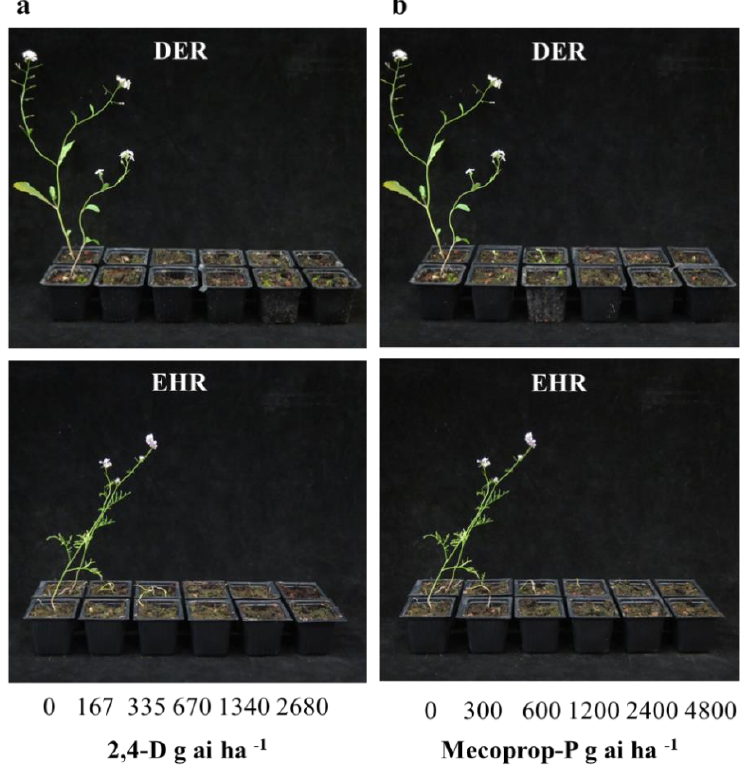
Figure 4. Effect of increasing rates of two auxinic herbicides on survival and shoot fresh weight of plants from D. erucoides (DER) and E. hispanica (EHR) ALS-resistant populations. Recommended rate for Mecoprop-P ( a ) and 2,4-D ( b ) are 670 and 1200 g ai ha −1 , respectively.